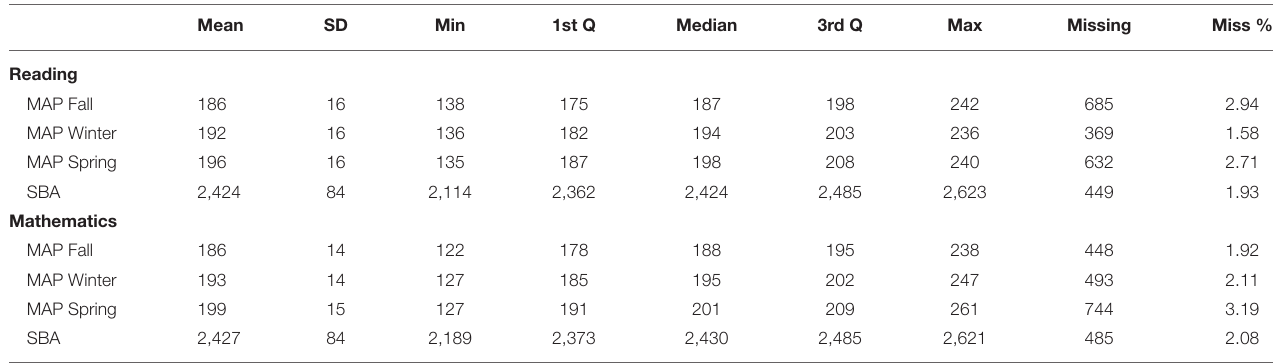
TABLE 2 | Descriptive statistics for the